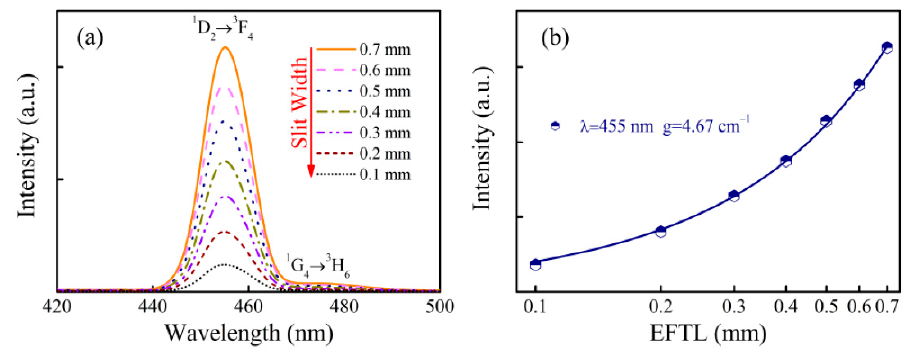
Figure 3. ( a ) ASE spectra of GT0.25 under 365 nm excitation when the EFTL is changed from 0.1 to 0.7 mm. ( b ) Dependences of emission intensity on the EFTL. 0.7 mm. ( b ) Dependences of emission intensity on the EFTL.